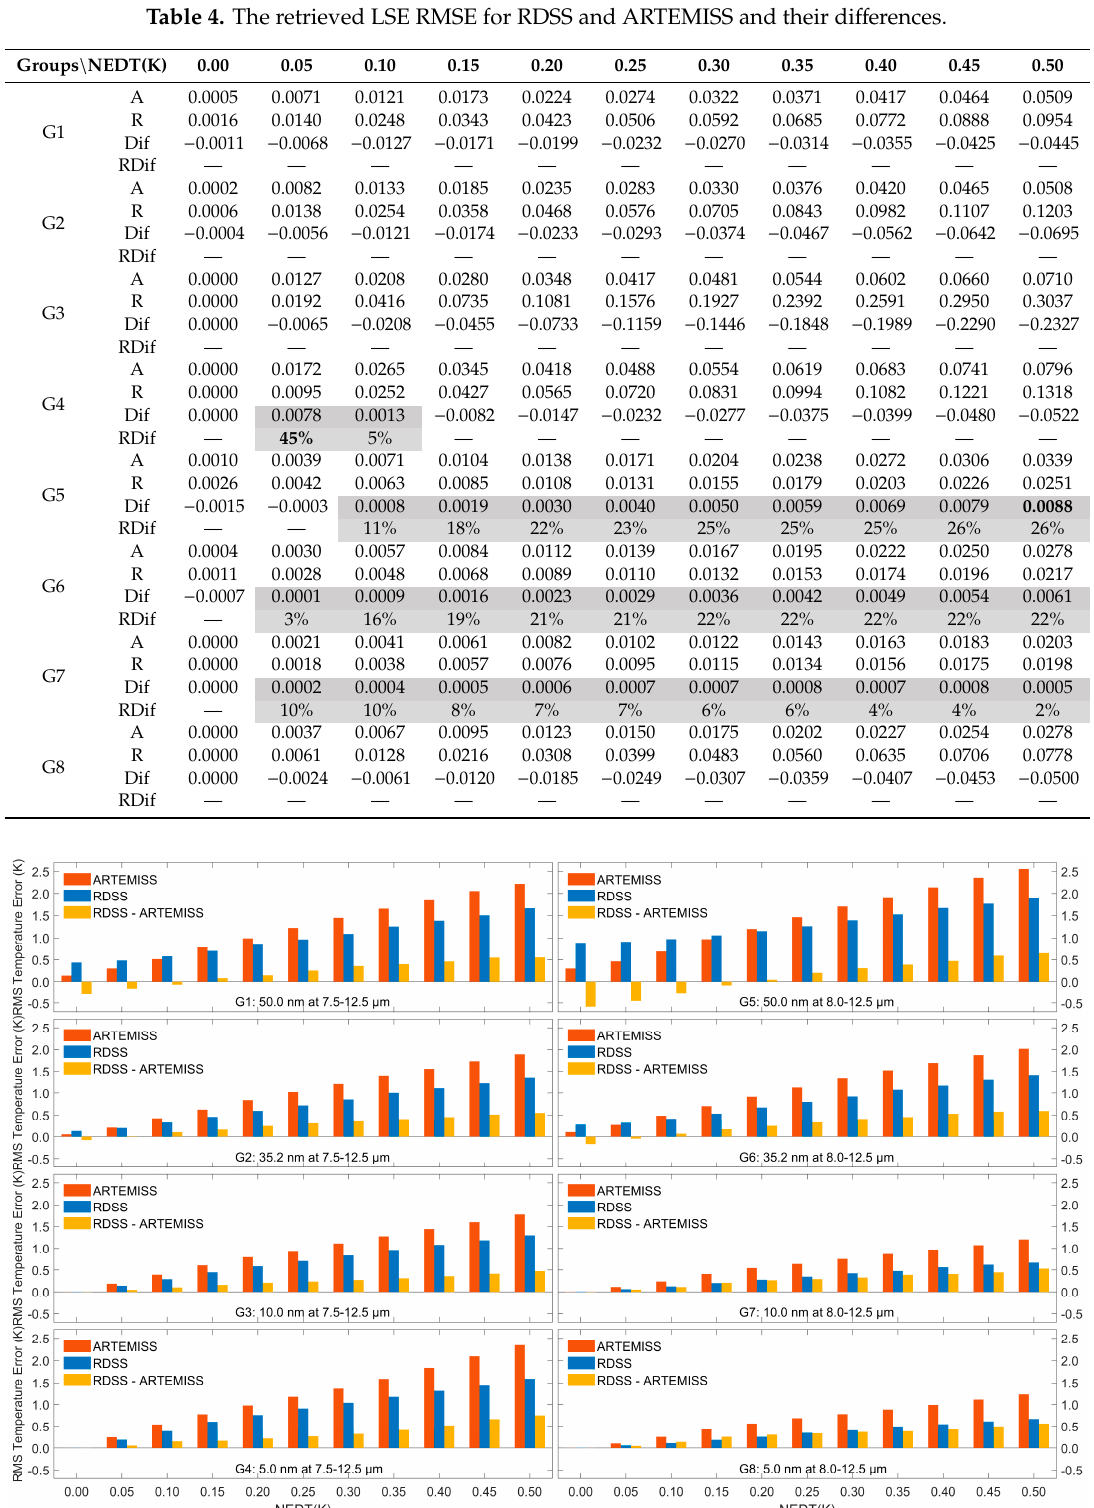
Figure 7. The comparison of the retrieved LST errors of RDSS and ARTEMISS. Table 3. The retrieved LST error list of the RDSS and ARTEMISS and their differences.